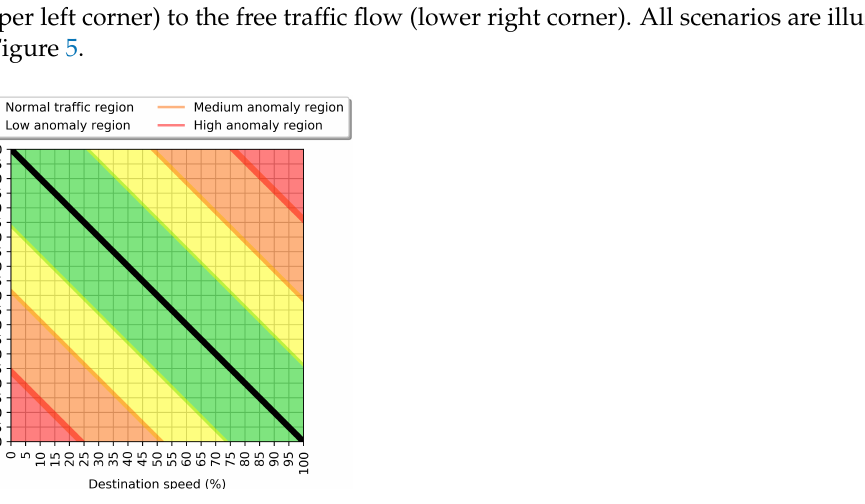
Figure 5. Regions in the STM that shows pattern location importance for anomaly